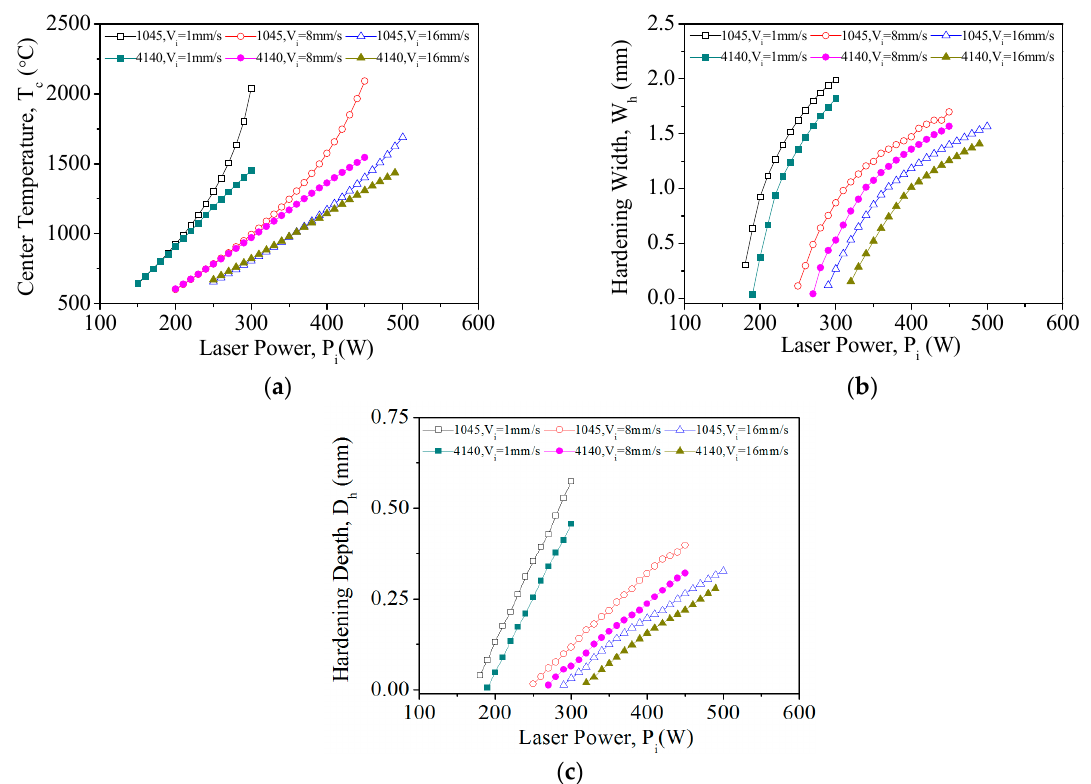
Figure 11. Single-track laser heat treatment. ( a ) Relationship between power and center temperature ( Tc ); ( b ) Relationship between laser power and hardening width; and ( c ) Relationship between hardening depth and laser power.